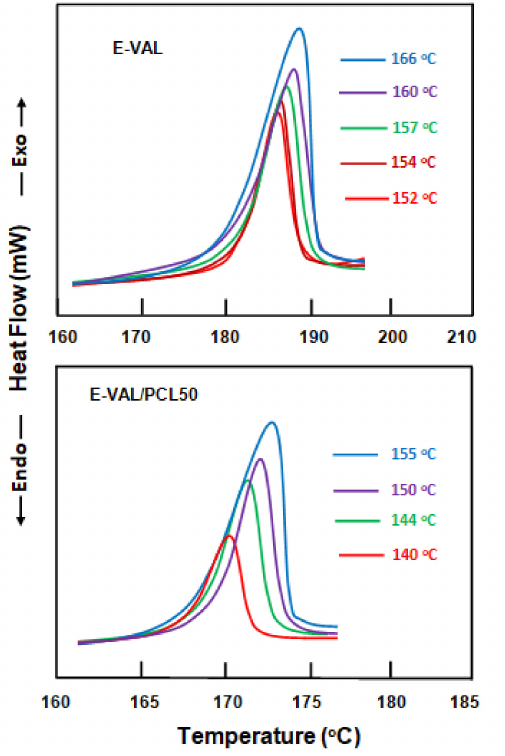
Figure 2. Dynamic DSC thermograms obtained after the isothermal crystallization of E-VAL, and the E-VAL/PCL50 blend at different T c .